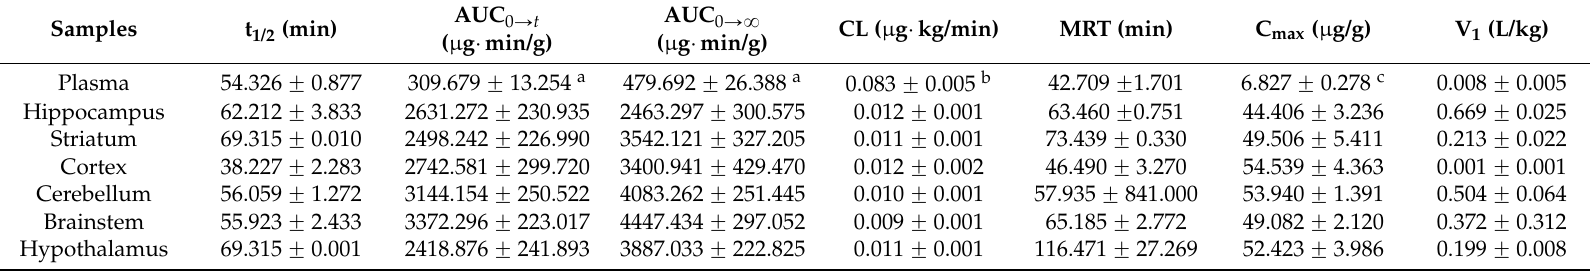
Table 3. Pharmacokinetic parameters of DDIE in rats plasma and cerebral nuclei after i.v. administration at a single dose of 40 mg/kg (mean ˘ SD, n = 5).